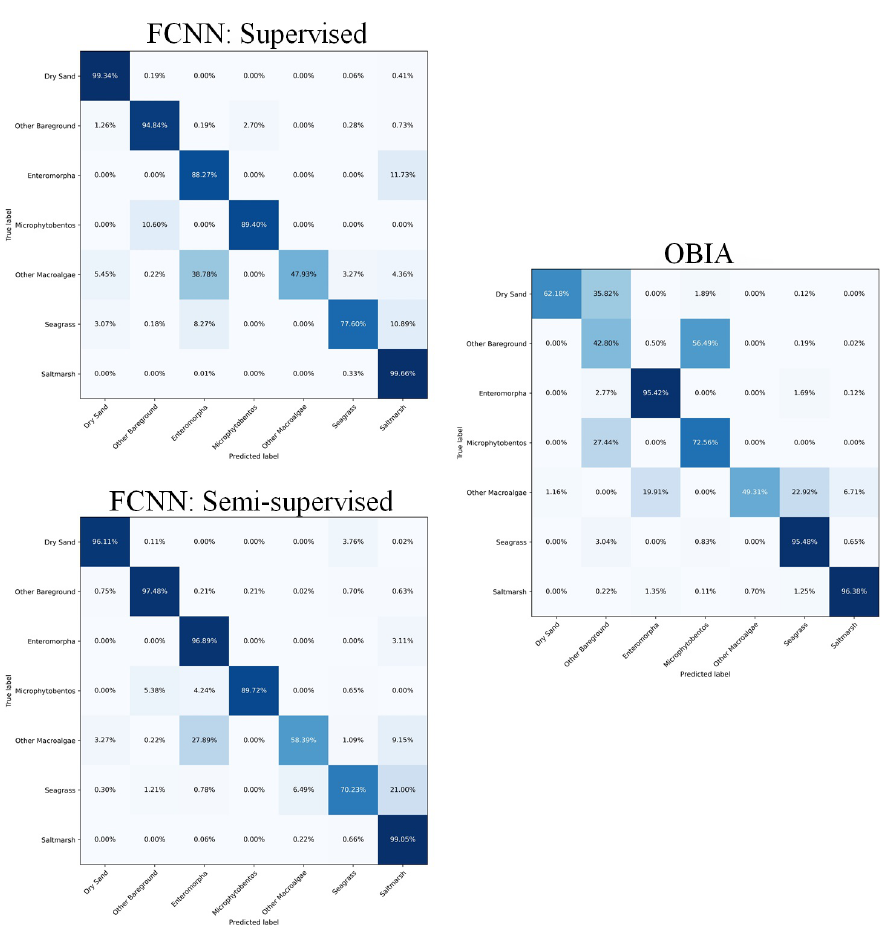
Figure 8. Confusion matrices for both methods using the RedEdge3 multispectral